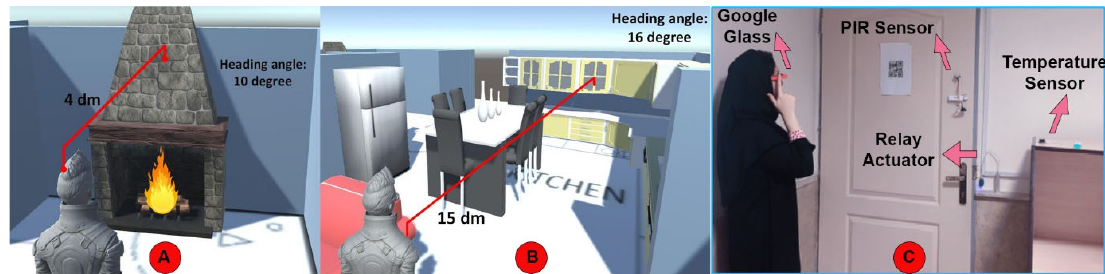
Figure 8. Illustration of the user interaction with home objects in ( A ) living room, ( B ) kitchen, and ( C ) experimental condition. The experimental condition was simulated on the Unity game engine to monitor the user’s indoor position and interaction with the smart objects. Table 2. Result of the experimental test. There were 20 experiments with various variations on the user’s localization data and IoT devices’ status. There were five different objects, and the user’s dis ‐ tance from them was measured simultaneously. The localization data can be varied through the user’s movement and heading angle. We also checked the activated fuzzy rule and its reliability in each experiment.